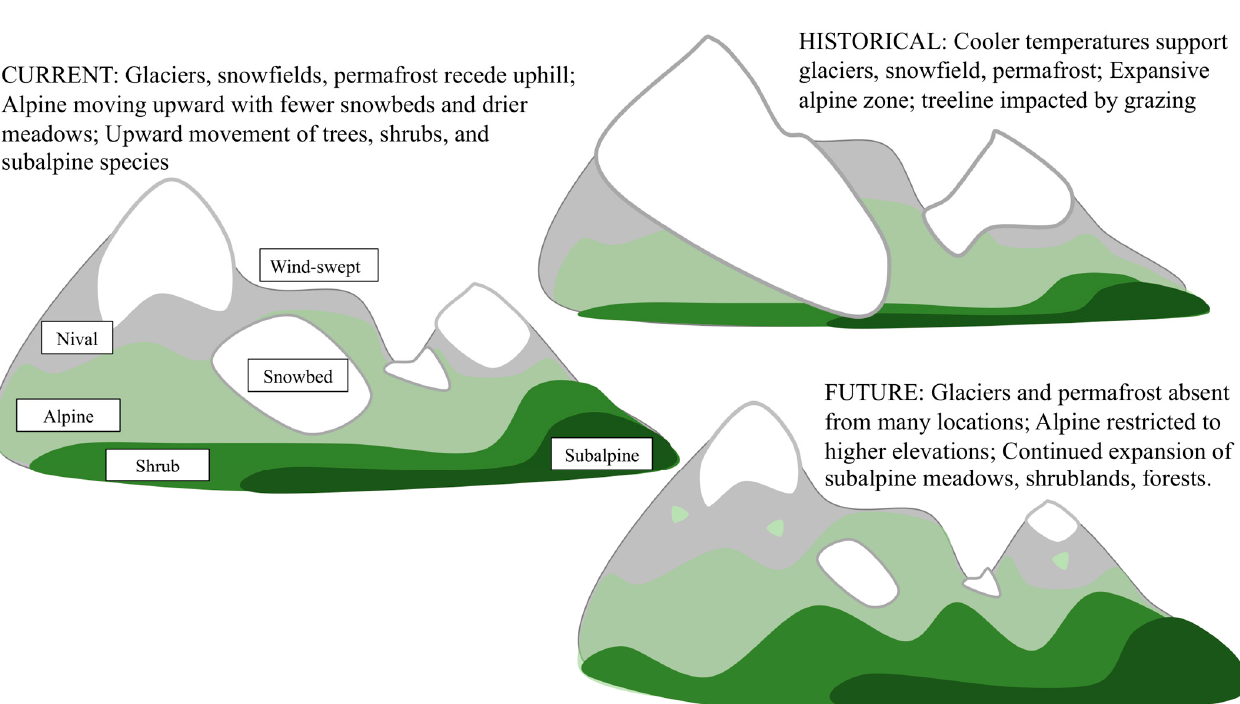
Figure 2. Directional warming of high elevation systems influences species whose life cycles have been largely controlled by amount of snow and snow duration. Historically, windswept surfaces remained snow-free most of the year, whereas snow redeposited into protected areas and at the tree line can remain snow-covered for much or even all of the growing season. Heating and seasonality of heating and light input to soil therefore occur along an elevational gradient and along the reduced-snow gradient, which can be separated to elevation relationships. The historical legacies (human use, grazing, etc.) also impose additional factors that affect vegetation dynamics.